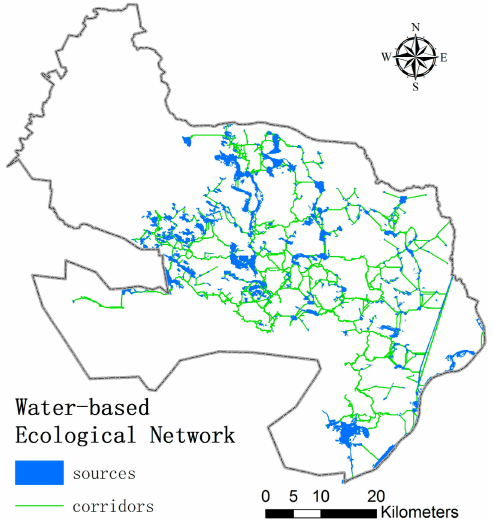
Figure 16. Water-based ecological network in Denko